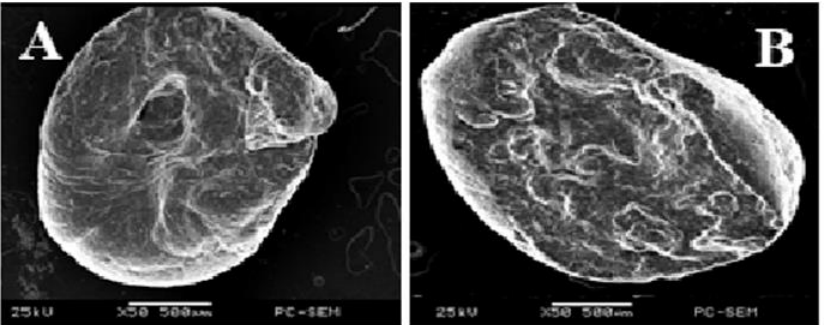
Figure 1. SEM image of alginate beads with encapsulated Azolla fern powder, showing the outer aspect ( A ) and cross-section ( B ).